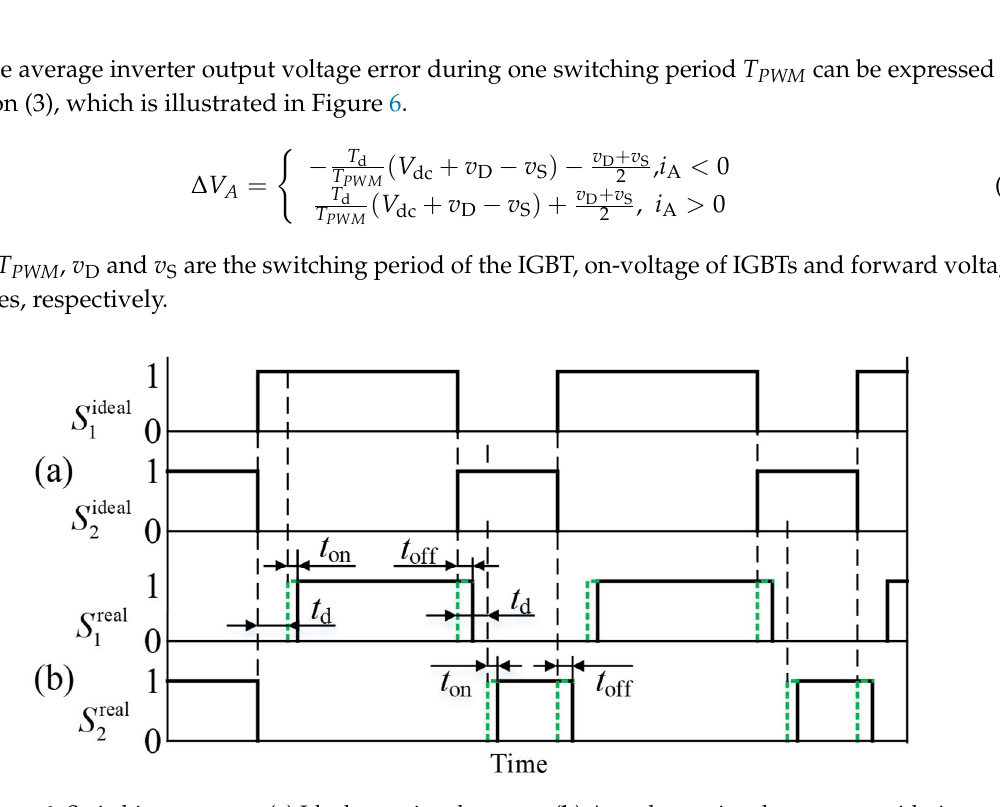
Figure 4. Switching patterns. ( a ) Ideal gate signal pattern; ( b ) Actual gate signal pattern considering turn on/off time and dead time.